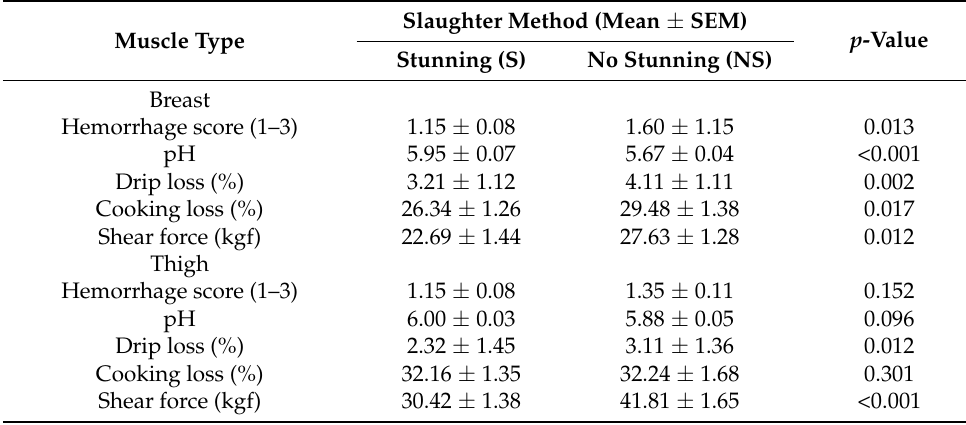
Table 1. The physical properties of breast and thigh muscles of broiler